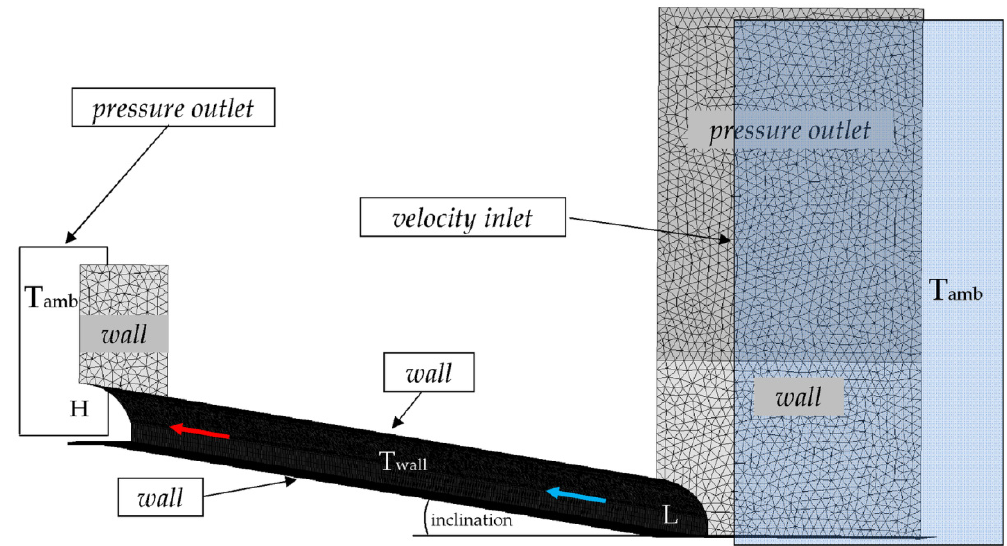
Figure 11. The structure of the numerical model of stack effect [15].